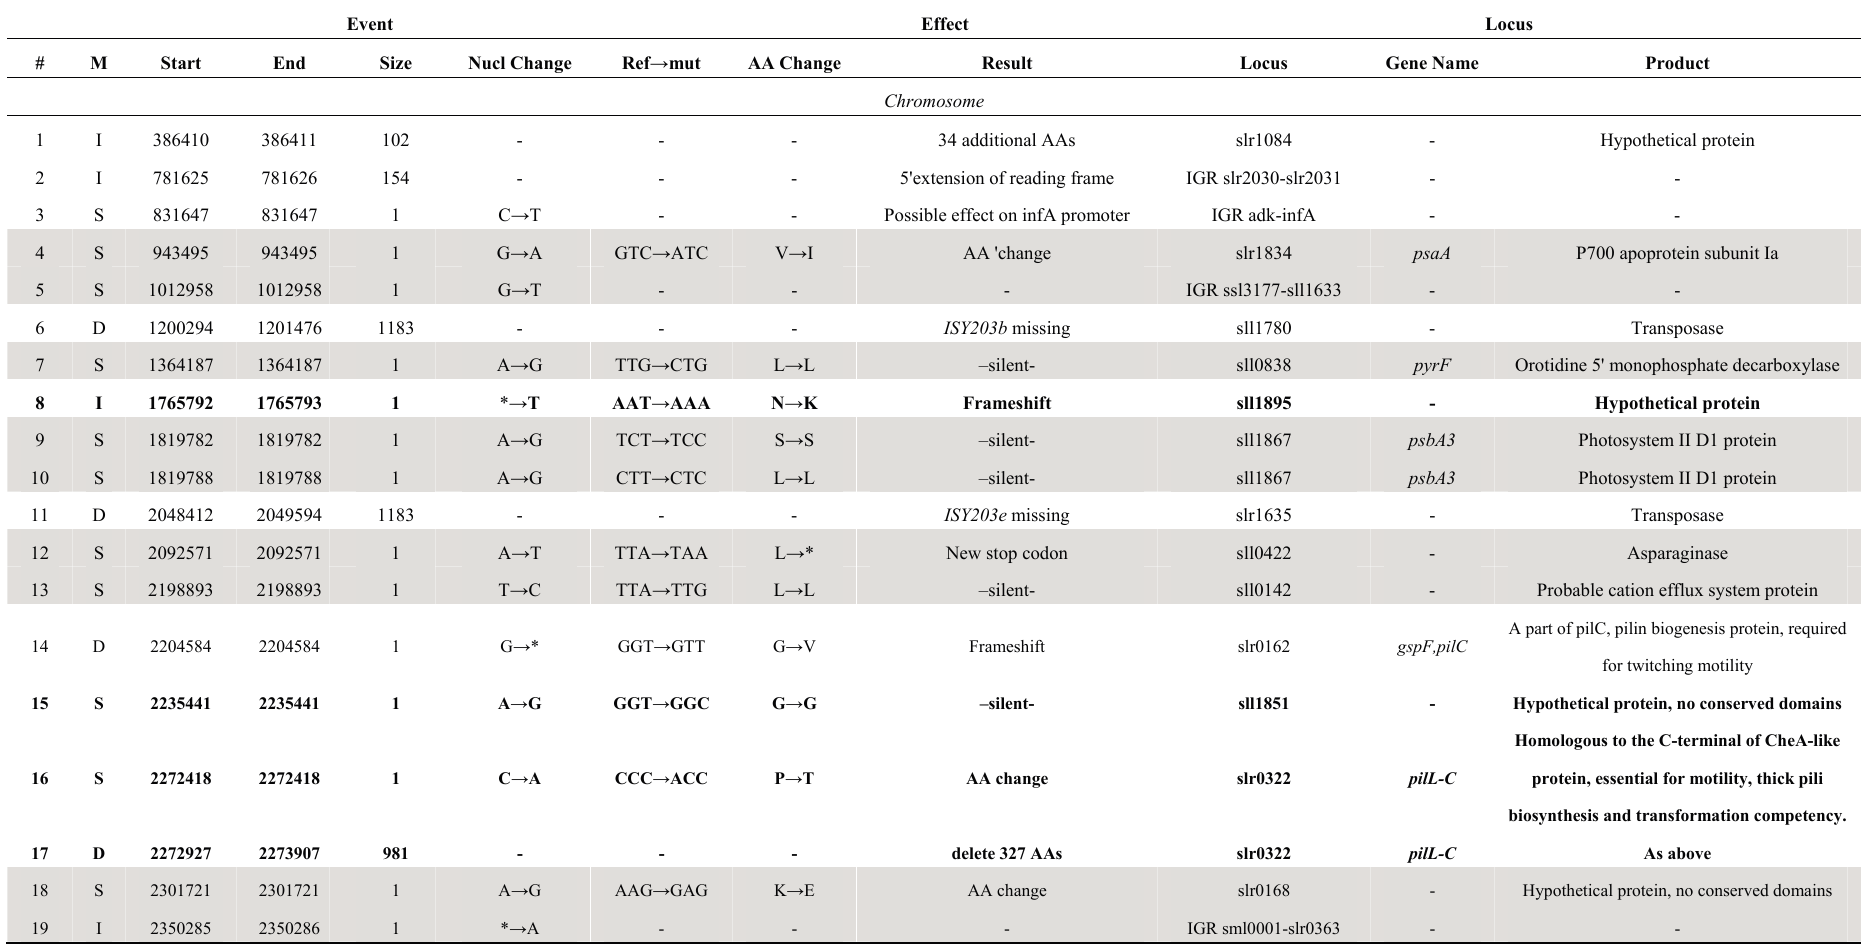
Table 1. Location and effects of SNPs and indels identified in GT-G compared with the nucleotide sequence of GT-Kazusa in the database. Specific variants identified in GT-G are highlighted in bold. The errors of database are in grey. SNP, insertions, deletions and intergenic region are labeled as S, I, D and IGR